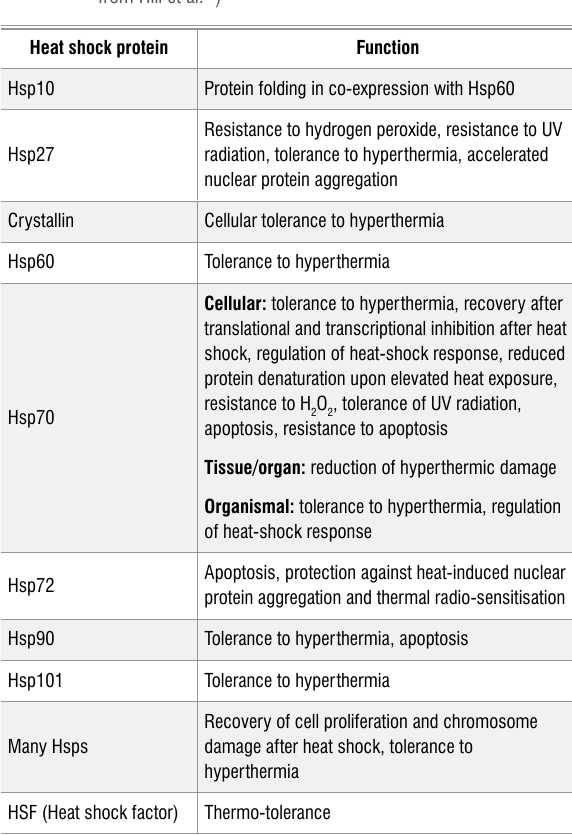
Heat shock proteins and their functions necessary for cellular regulation during thermal stress of the coral host (adjusted from Hill et al. 21